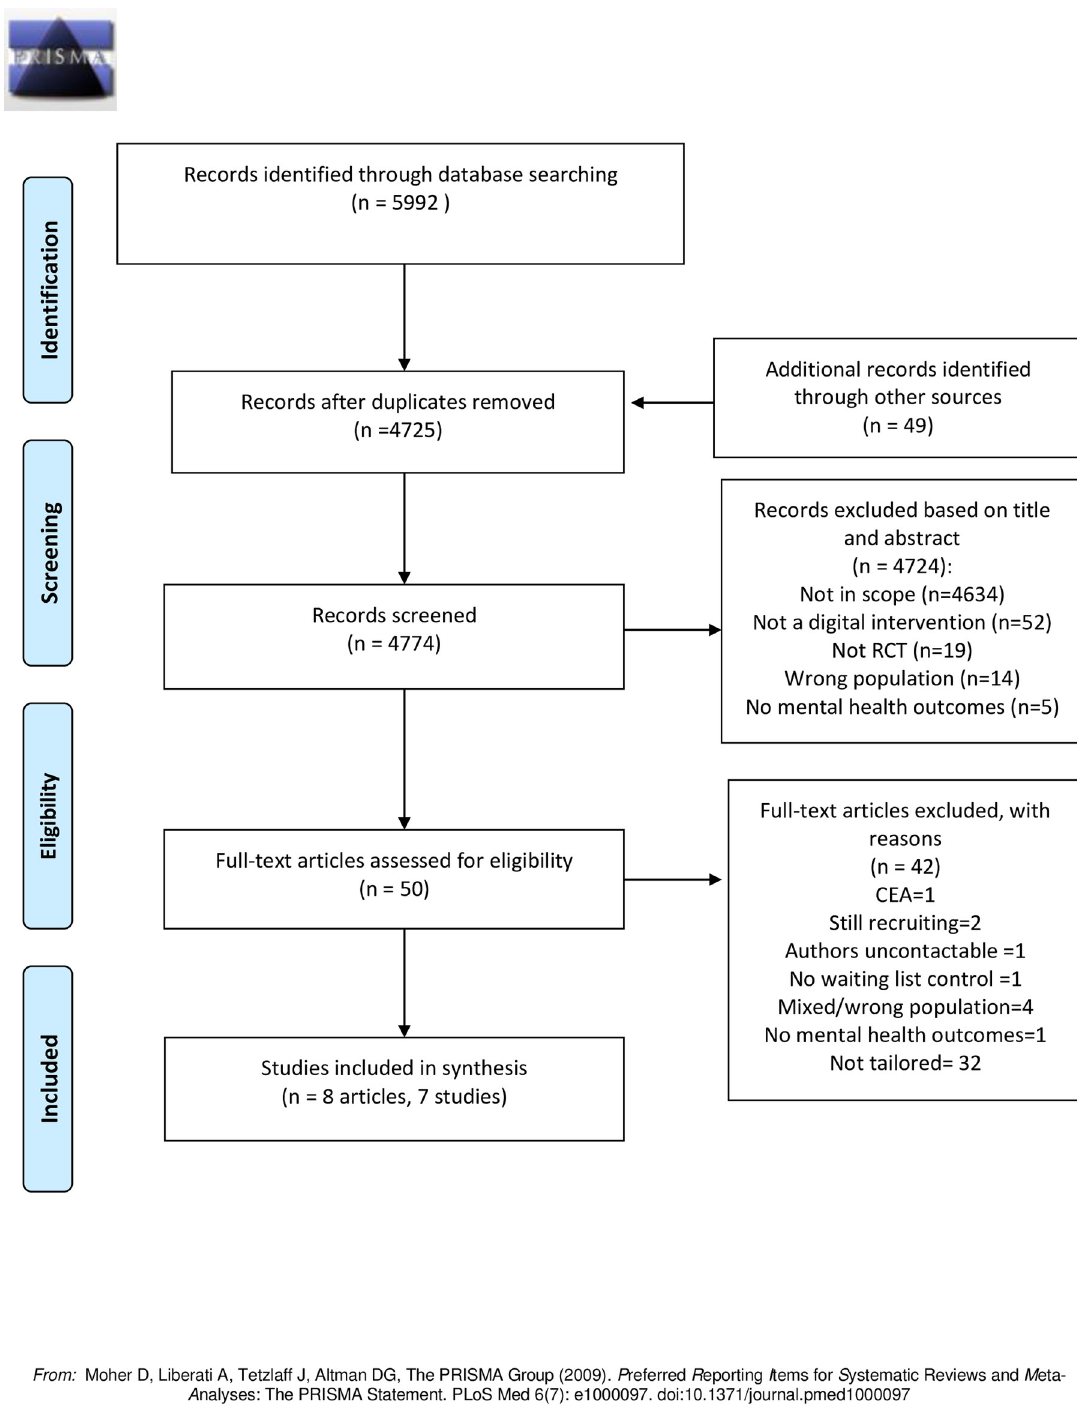
Fig 1. PRISMA 2009 Flow